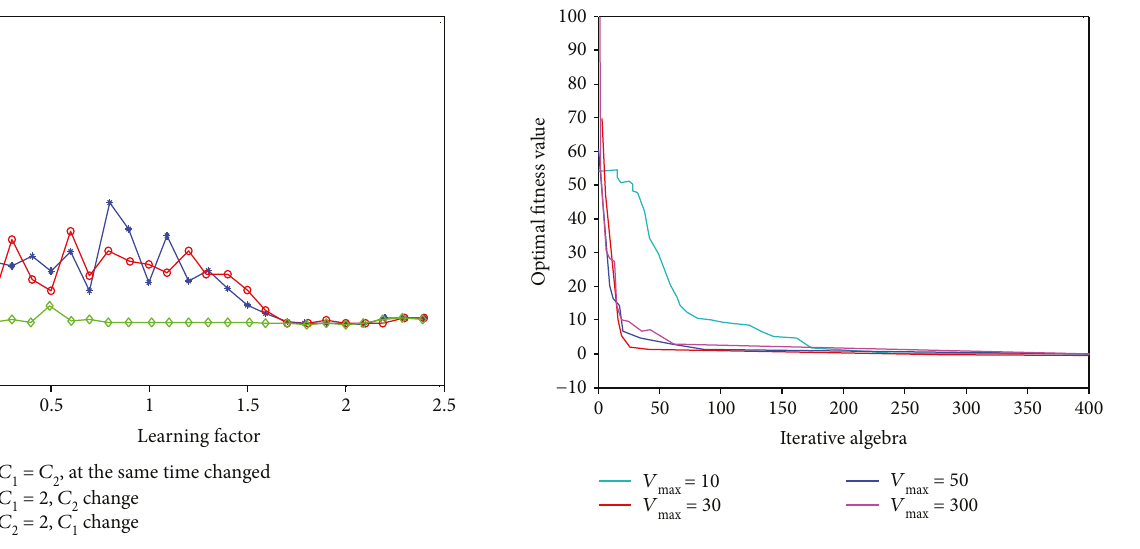
Figure 10: The in fl uence of learning factors on algorithm performance.